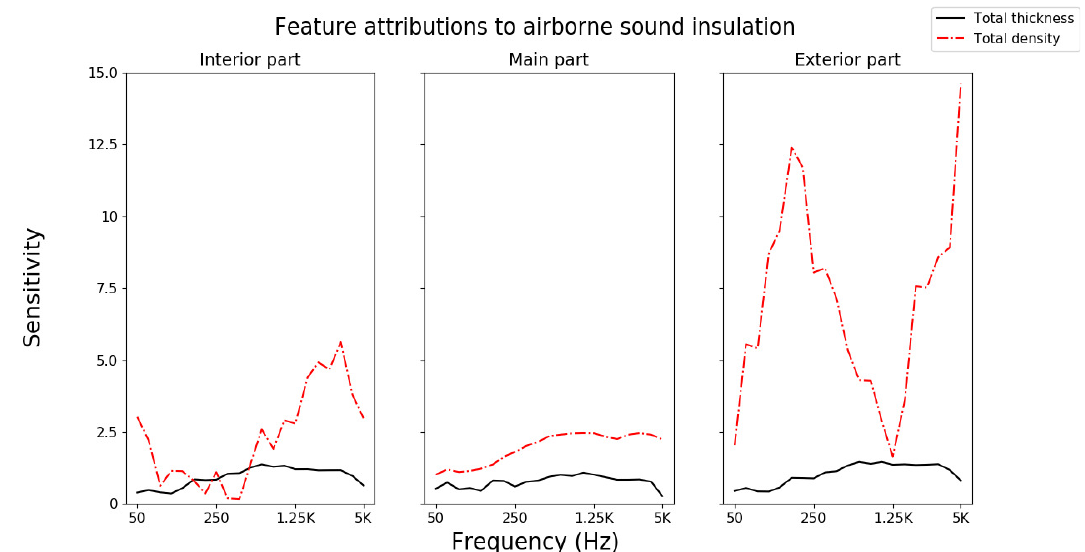
Figure 8. Feature attributions of interior, main and exterior parts façade structures to predictions of airborne sound